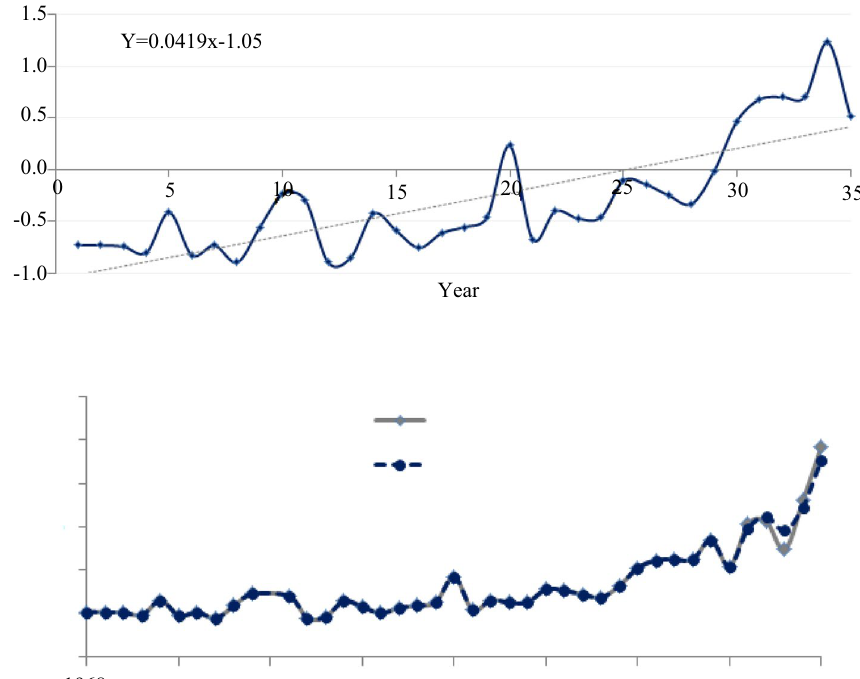
Fig. 5 Uniform time classifica- tion of Cl − and the assessed values for 5 years